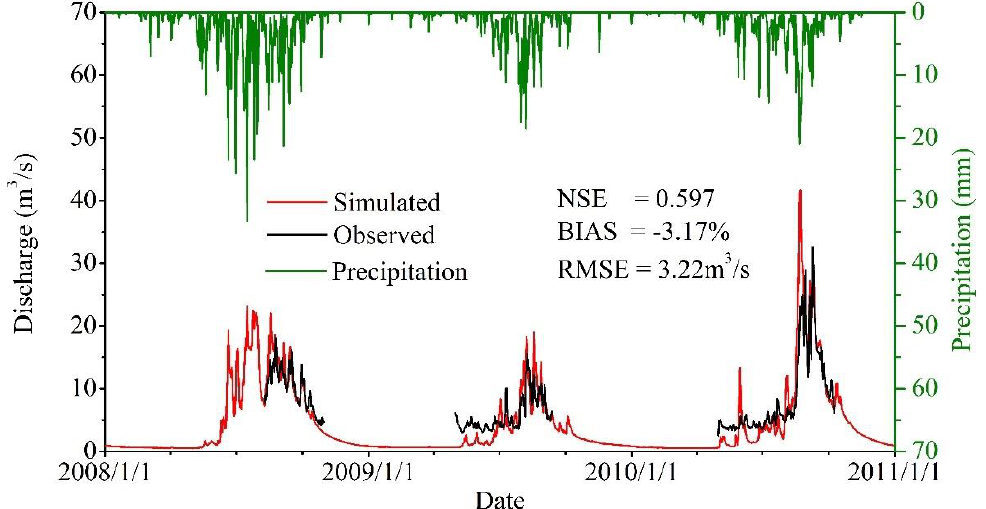
Figure 4. Daily observed and simulated discharge at Niyaqu Station from 2008 to 2010, and daily precipitation in the same period.